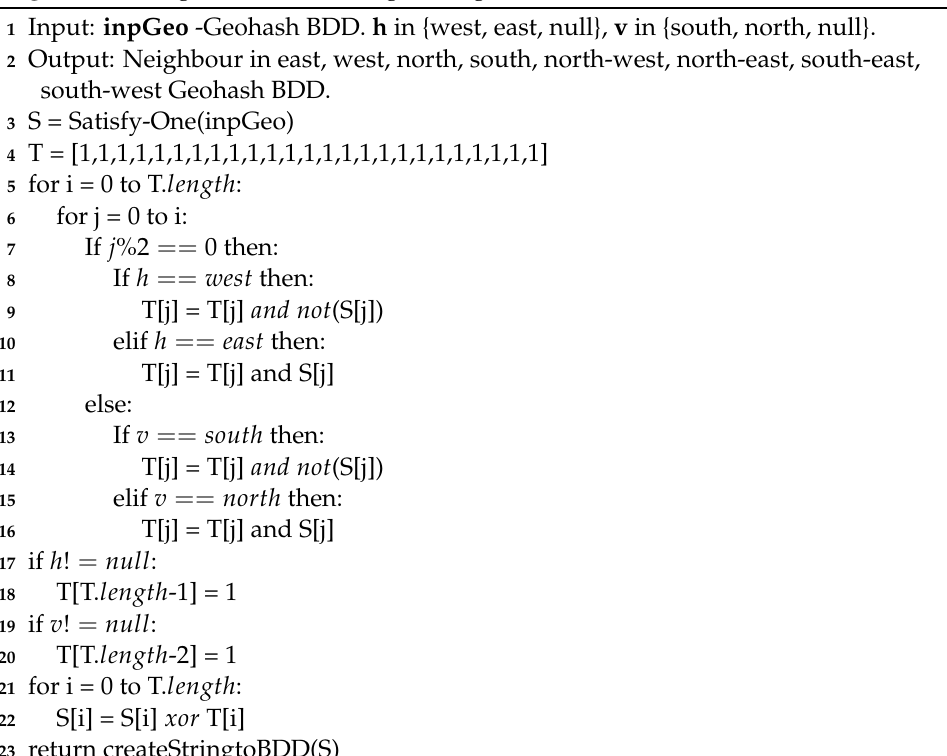
Algorithm 1: Algorithm to find neighboring Geohash